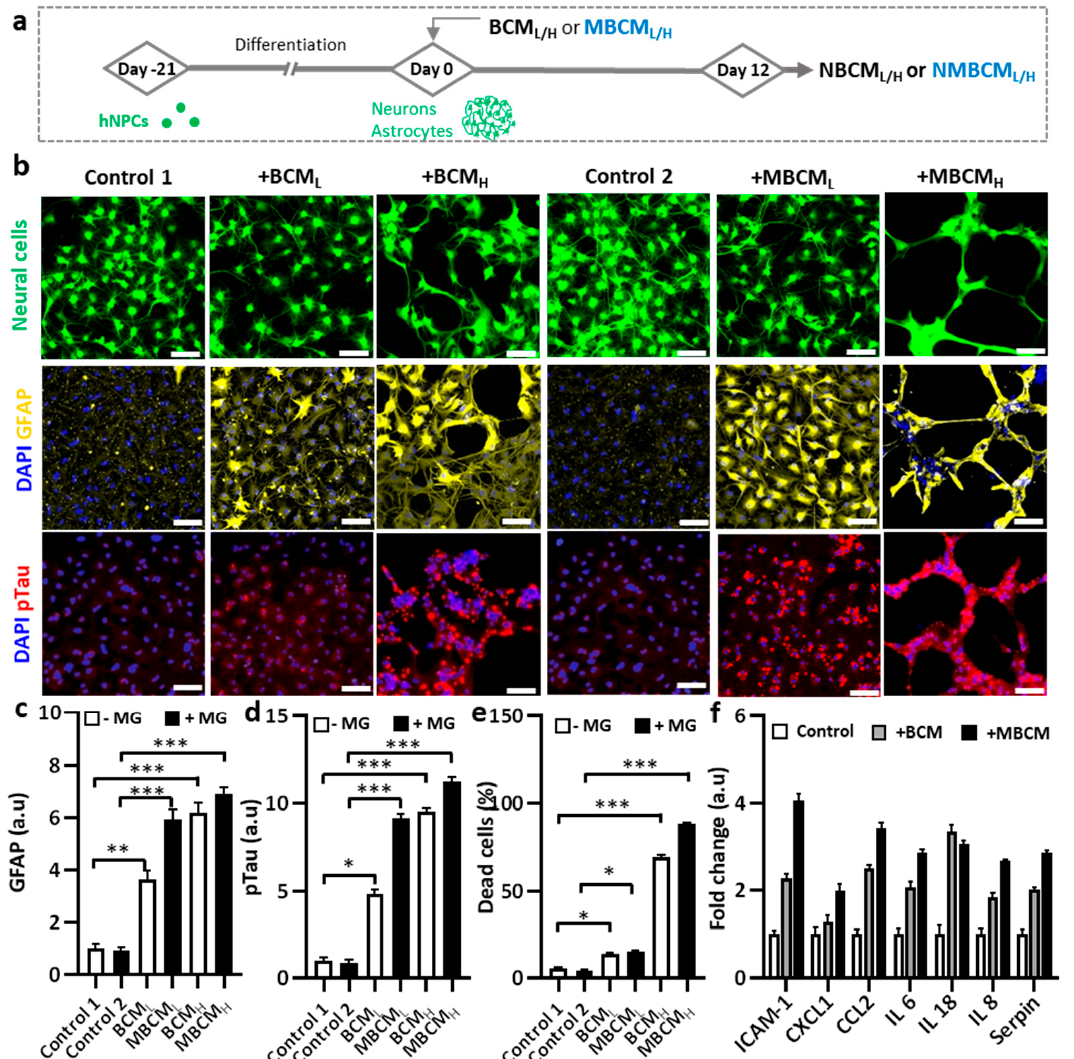
Figure 3. Neurodegeneration initiated by different bacteria-conditioned media (BCM L/H ) and microglia-derived media containing bacterial metabolites (MBCM L/H ). ( a ) Schematic diagram showing experimental timeline for astrogliosis and neurodegeneration. ( b ) Morphological changes in neurons/astrocytes (green) treated with bacterial conditioned media and microglia-stimulated conditioned media. Fluorescent images of GFAP and pTau staining of neurons/astrocytes after 12-day exposure. Scale bar, 100 µ m. ( c , d ) Quantification of GFAP and pTau level in neurons/astrocytes. ( e ) Neural cells loss is quantified by measuring dead cell ratio. ( f ) Quantification of cytokines from astrocyte conditioned media. All experiments were repeated three times independently and statistically analyzed by One-way ANOVA followed by Tukey HSD test (* p < 0.05, ** p < 0.01 and *** p < 0.001). All data were presented as mean ± standard deviation (SD).